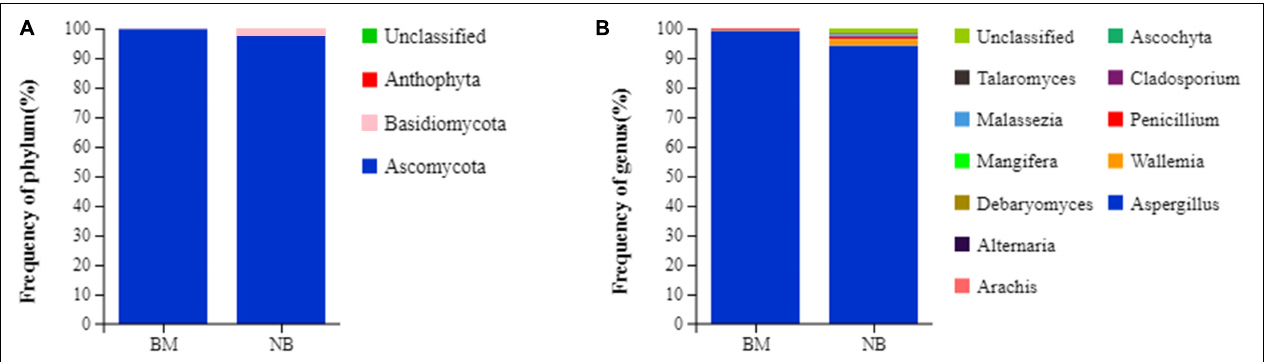
FIGURE 2 | Relative abundance of fungal community proportions at the phylum (A) and genus (B) levels in Mianning ham.